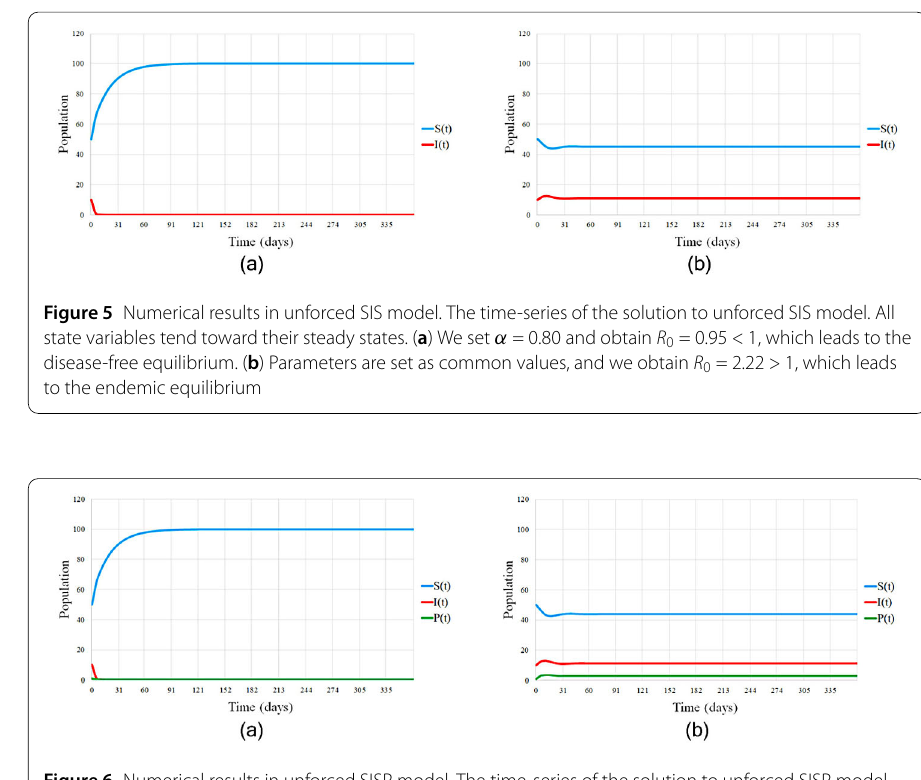
Figure 6 Numerical results in unforced SISP model. The time-series of the solution to unforced SISP model. All state variables tend toward their steady states. ( a ) We set α = 0.80 and obtain Λ R P 0 / μ = 0.97 < 1, which leads to the disease-free equilibrium. ( b ) We set b = 0.20 and obtain Λ R P 0 / μ = 2.28 > 1, which leads to the endemic